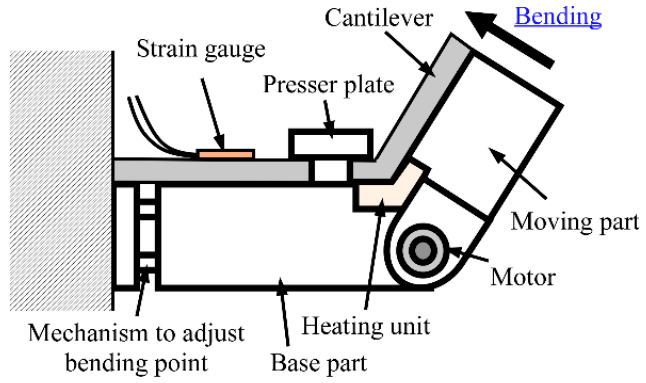
Figure 14. Jig used to bend and heat FS.